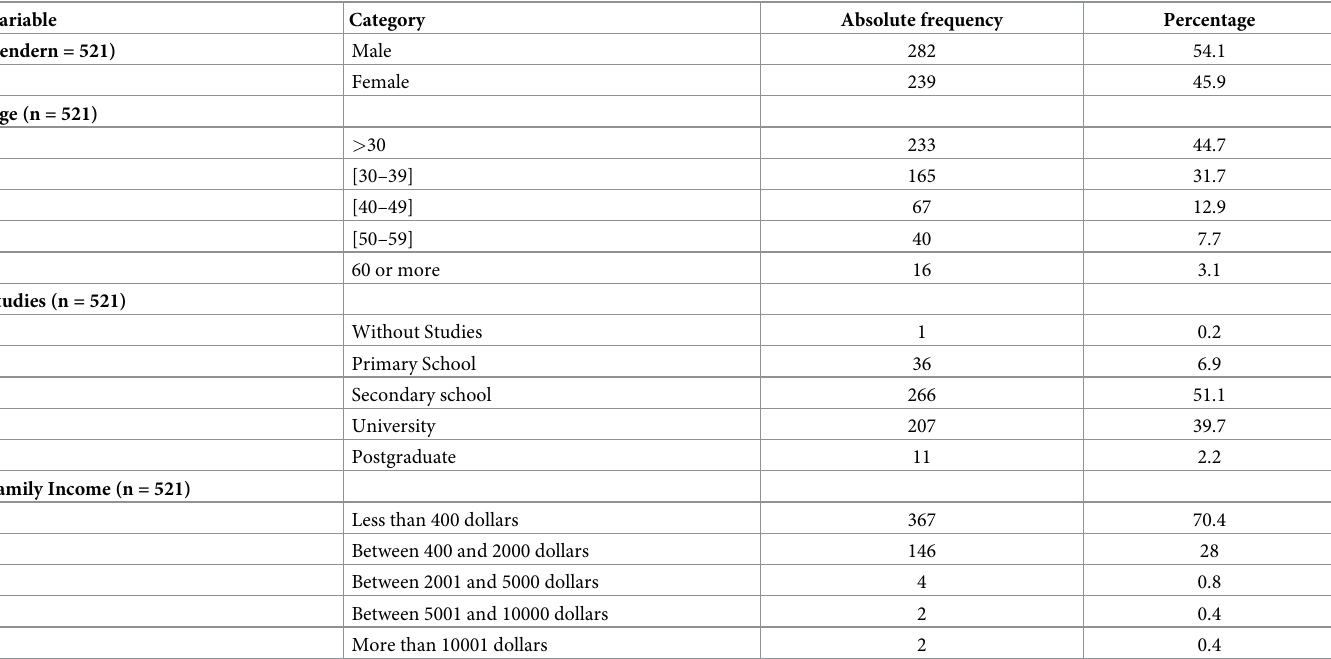
Table 2. Sociodemographic